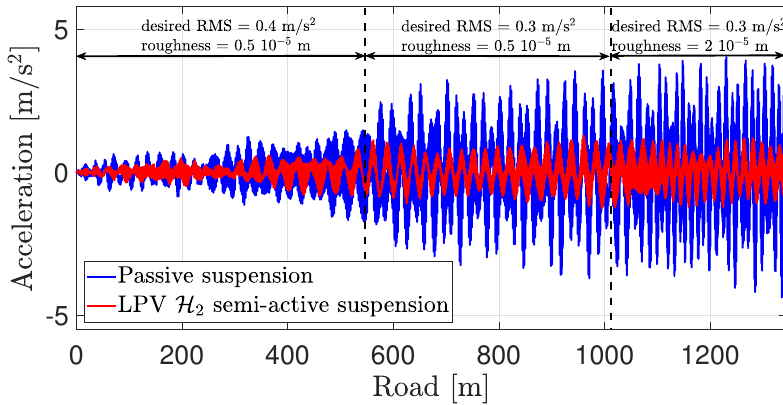
Figure 22. Resulting acceleration felt by passengers (filtered by (14)).